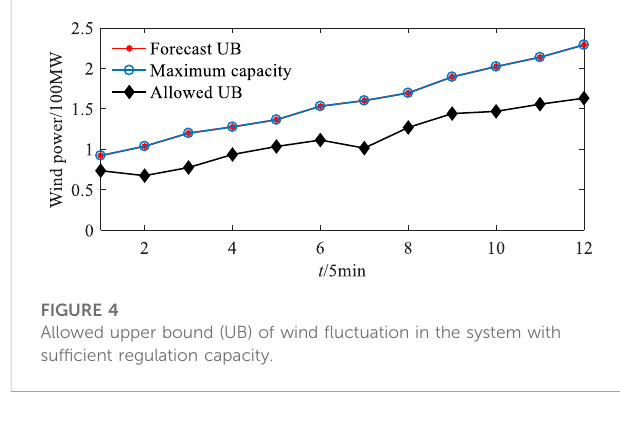
FIGURE 1 Overall fl owchart for the convexi fi ed solution.